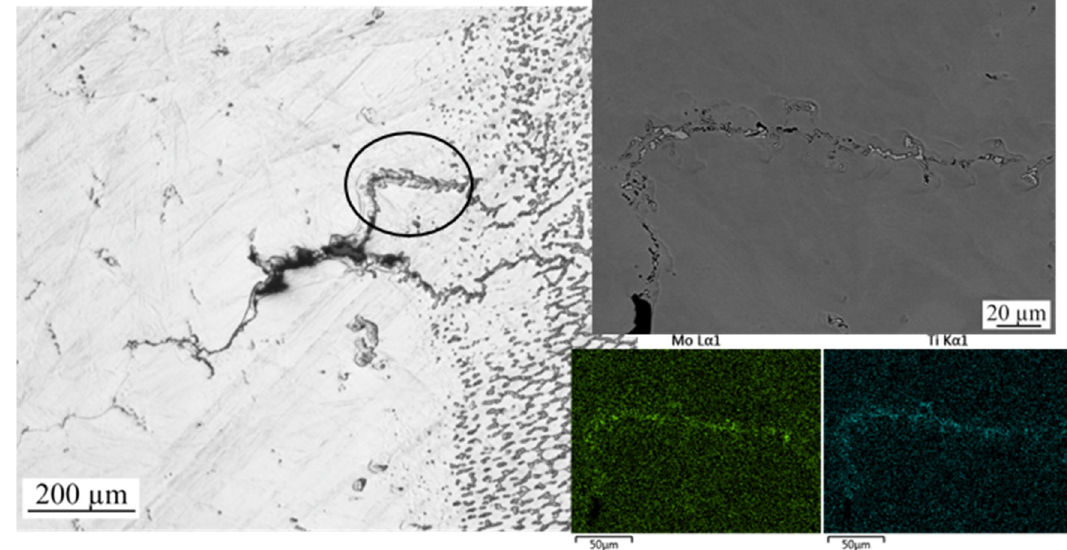
Figure 8. HAZ liquation cracking showing crack with backfilled liquid from fusion zone enriched in Mo and Ti.